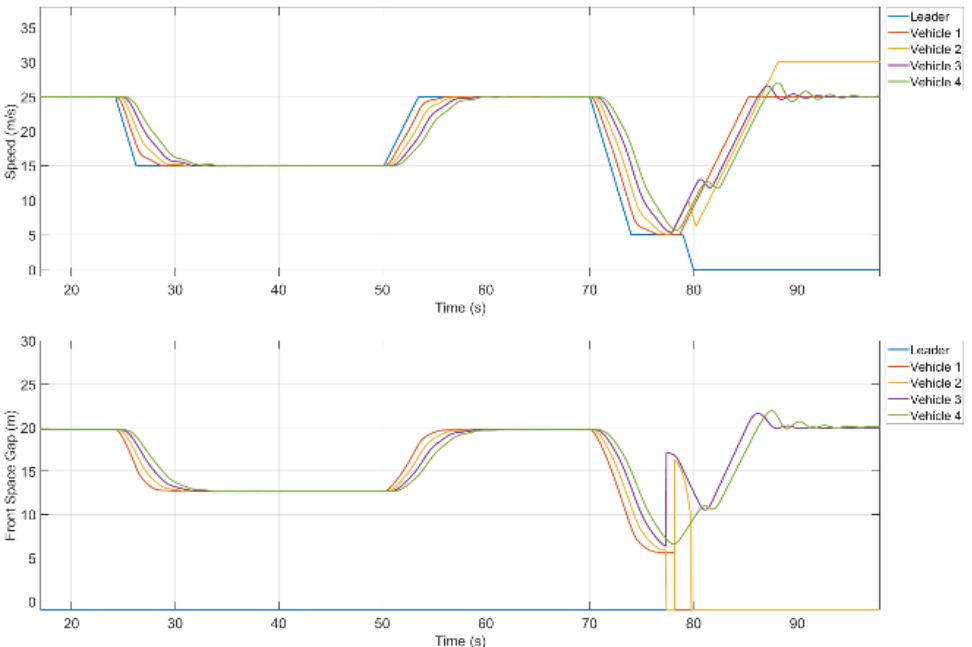
Figure 14. Simulation results of speed ( upper ) and inter-vehicle distance ( lower ) for safe scenario.